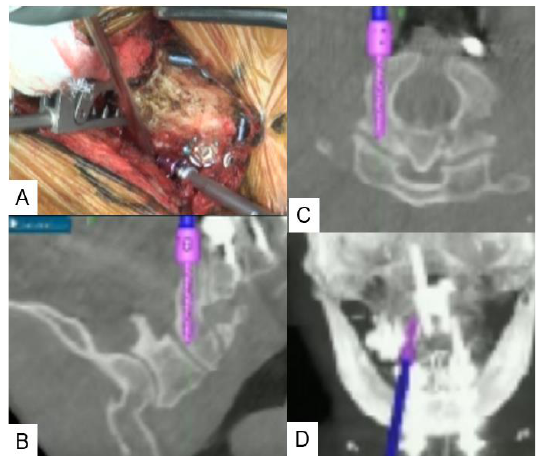
C2 pedicle screw ( A ): intra-operative image, ( B ): sagittal view, ( C ): axial view, ( D ): coronal